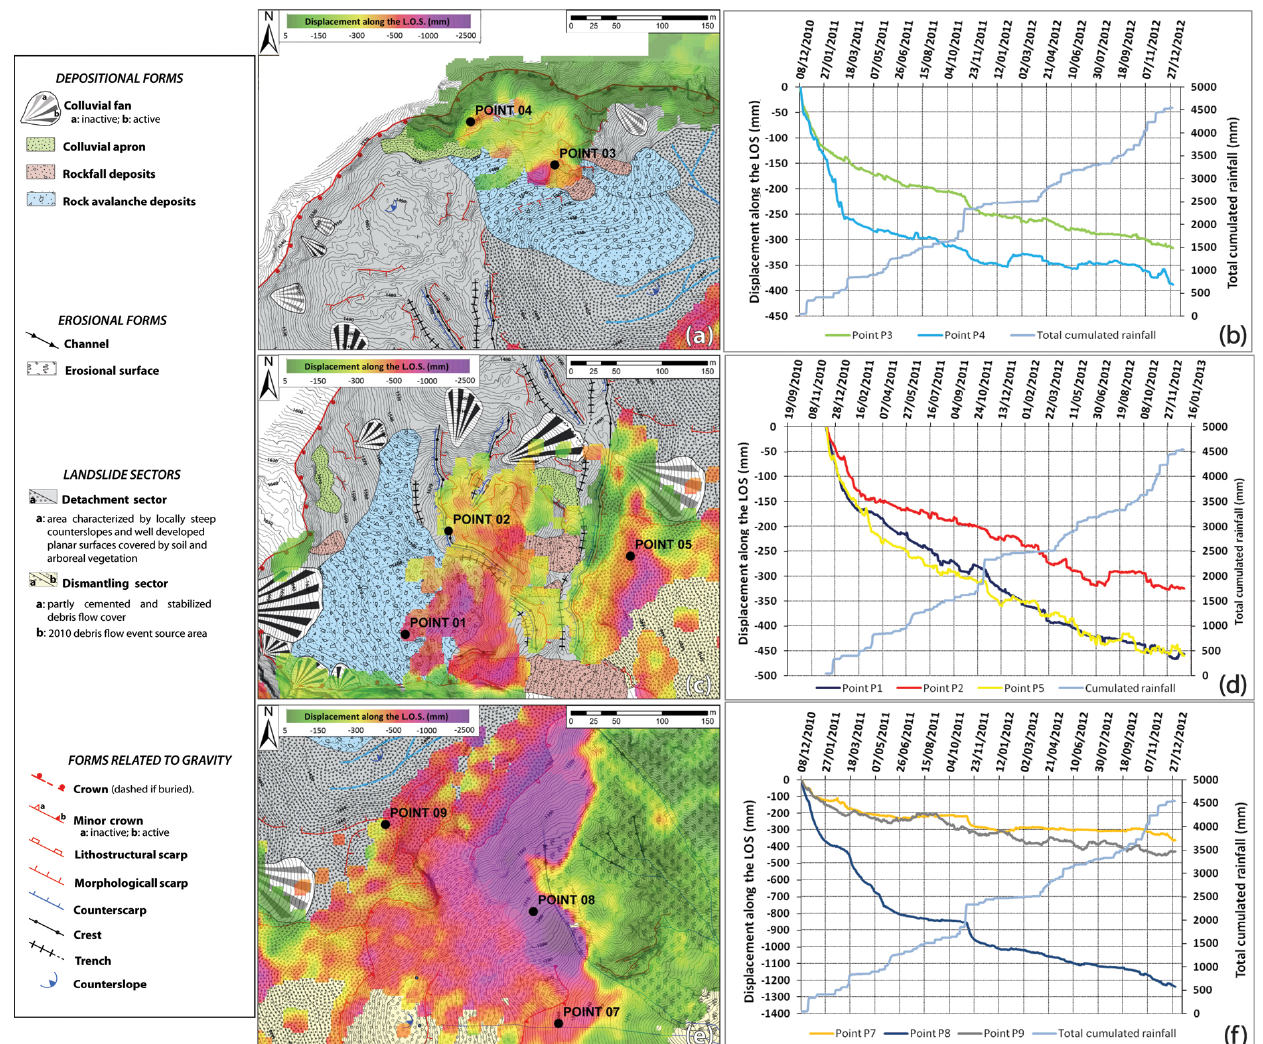
Figure 11. Integration between geomorphological map (modified after Frodella et al., 2014), the ICD maps displacement maps of whole monitored period, and the control points displacements time series: (a) the zoom of the Area 1 shown in Fig. 7d; (b) the displacements time series of P4 and P3; (c) zoom of the Area 2 and Area 3 shown in Fig. 7d; (d) the displacement time series of points 1, 2, and 5; (e) zoom of Area 4 shown in Fig. 7d; (f) the displacement time series of points 7, 8, and